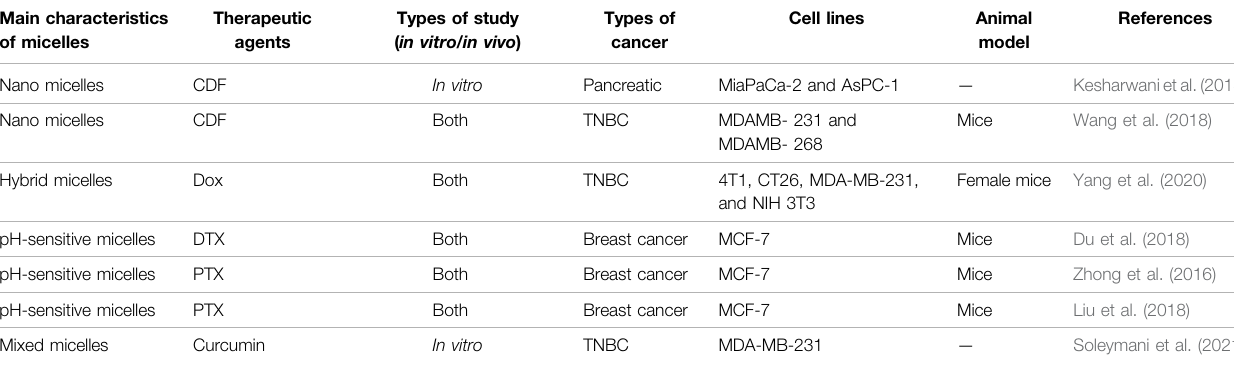
TABLE 6 | Examples of micelle-targeted CD44